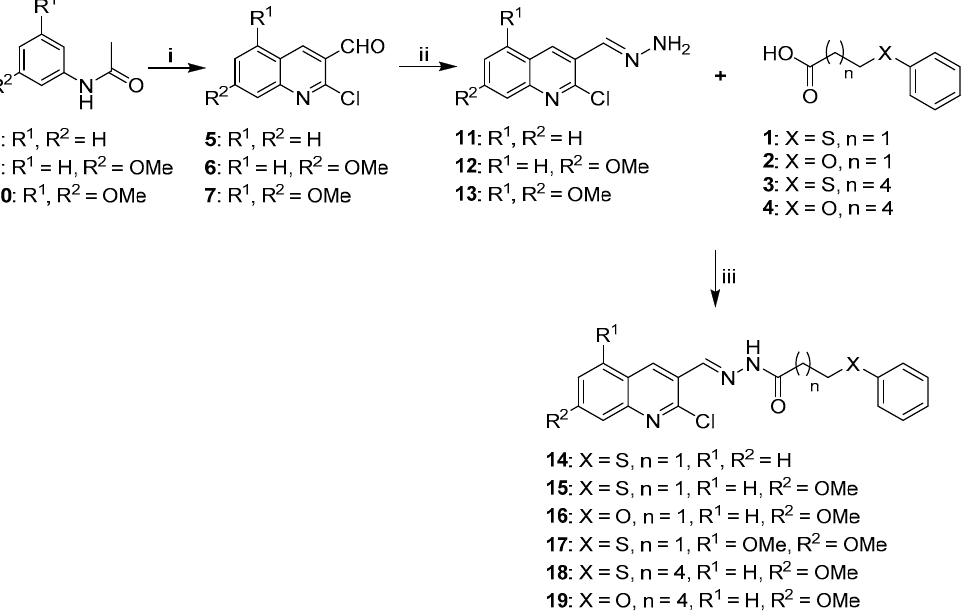
Scheme 1. Synthesis of quinoline-based hydrazide-hydrazones. Reagents and conditions : i. DMF, POCl 3 ,